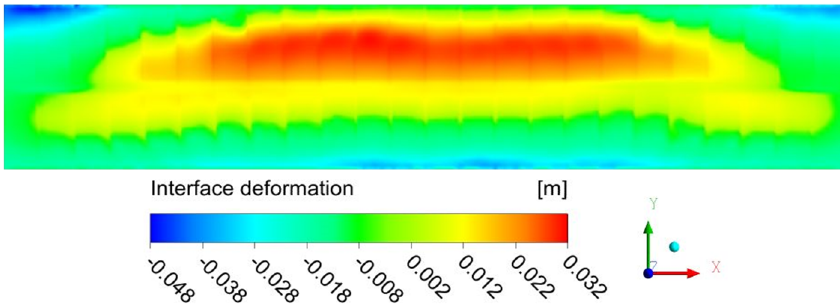
Figure 3. Bath/metal interface deformation of reference state (m).